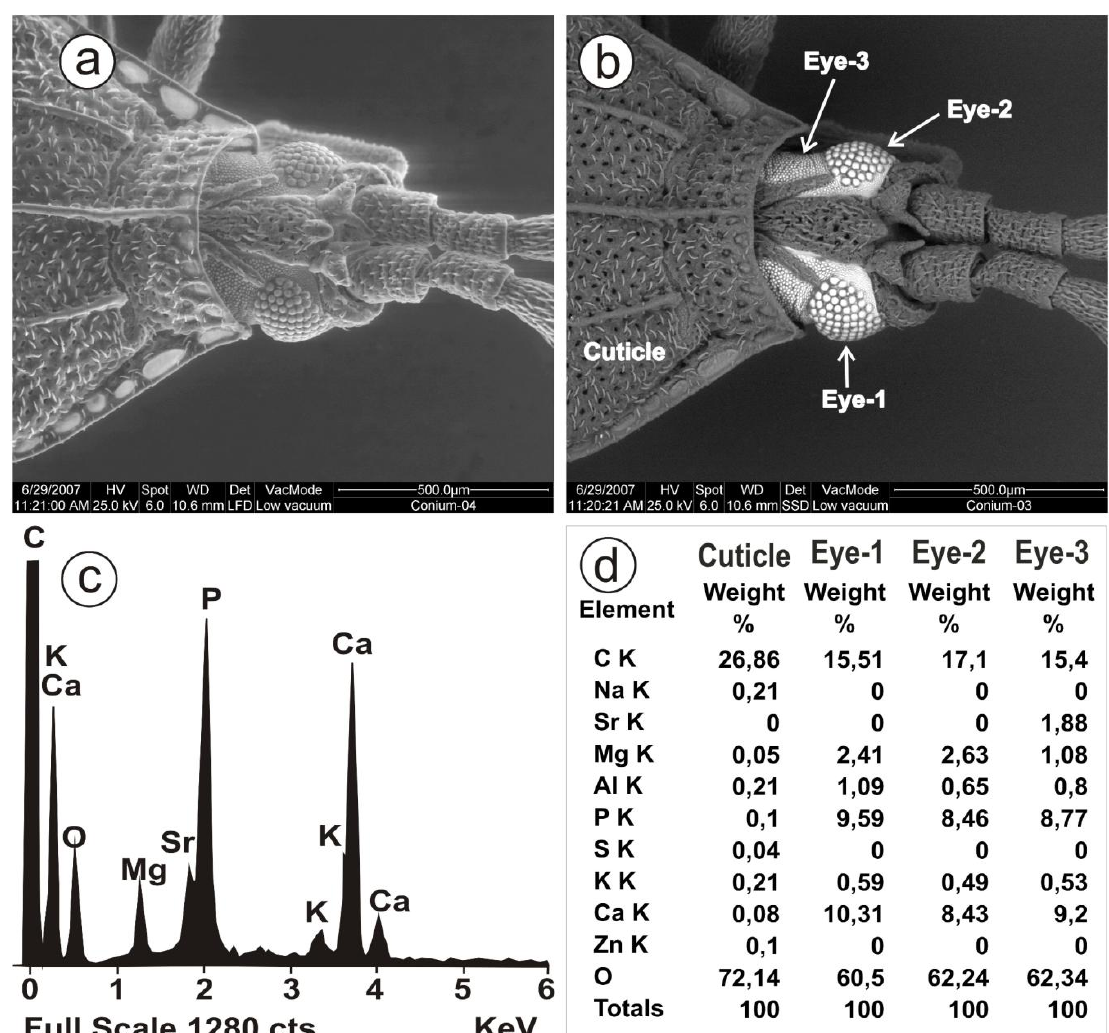
FIGURE 3. Copium eye ommatidium chemical EDS analyses. (a) Detail of the ESEM image under secondary electrons; (b) the same ESEM image by backscattering, including the spot analyses positions; (c)